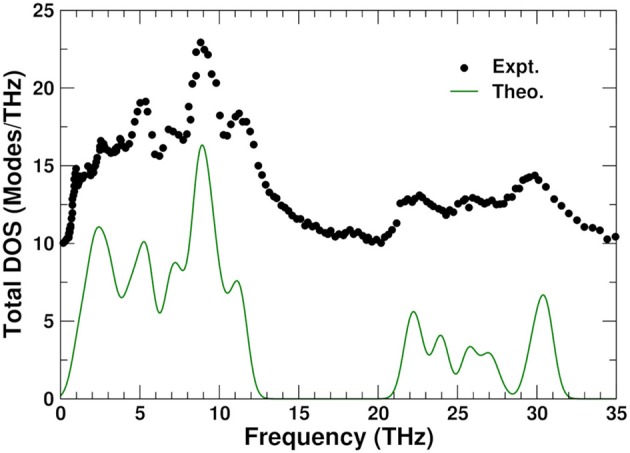
Comparison of the theoretical (0 K) and experimental (Ernst et al., 1998) (300 K) total phonon density of states (DOS) in ZrW2O8. The experimental result has been vertically shifted for clarity.